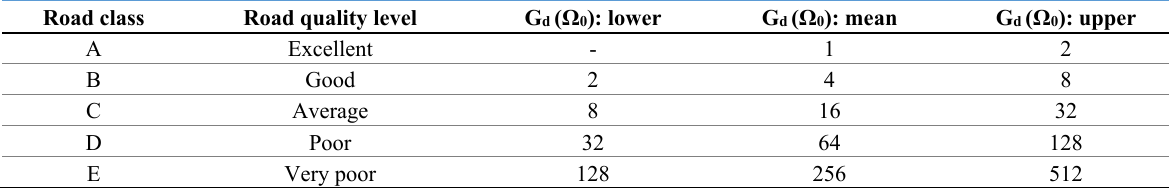
Table 2. Average values of G d (Ω 0 ) for different levels of road quality (in cm 3 ) [12]. Road